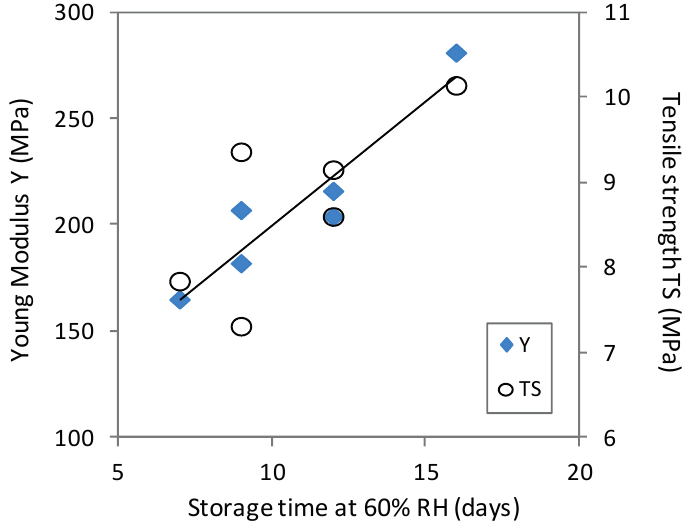
Figure 2. Isohume stress-strain tests of ~0.04 mm CaCas/Gly films in the closed DMA-RH chamber: TS and Y as a function of length-of-storage at 60%